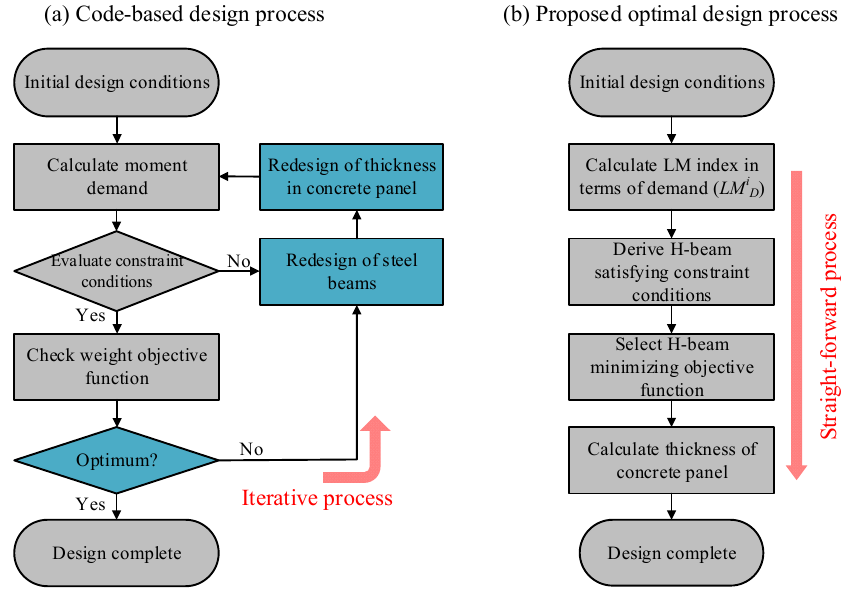
Figure 8. Optimization process in code-based design and proposed optimal design methods.